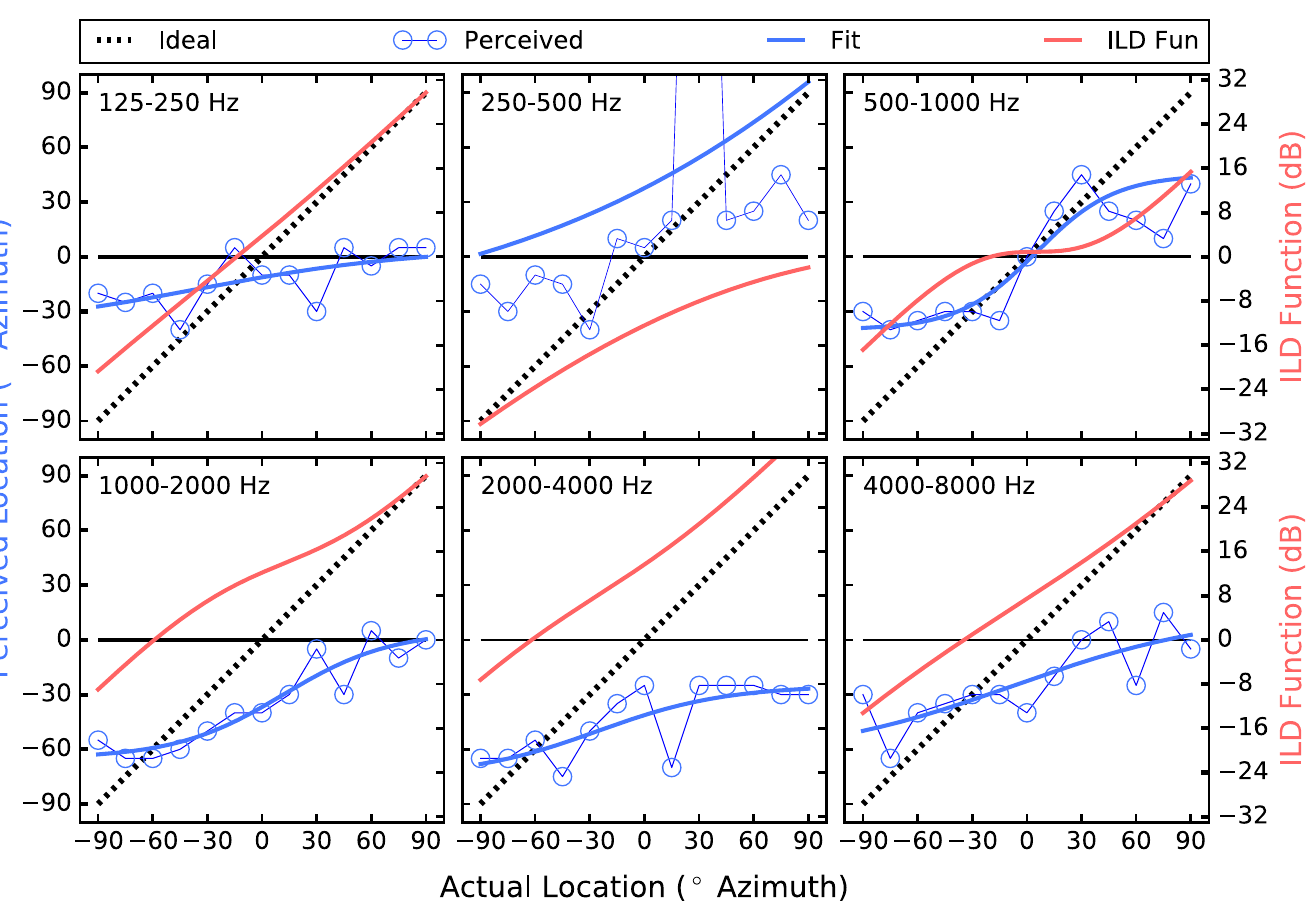
Fig 5. Corrective ILD generation data for participant 643. The layout is identical to that of Fig 1.